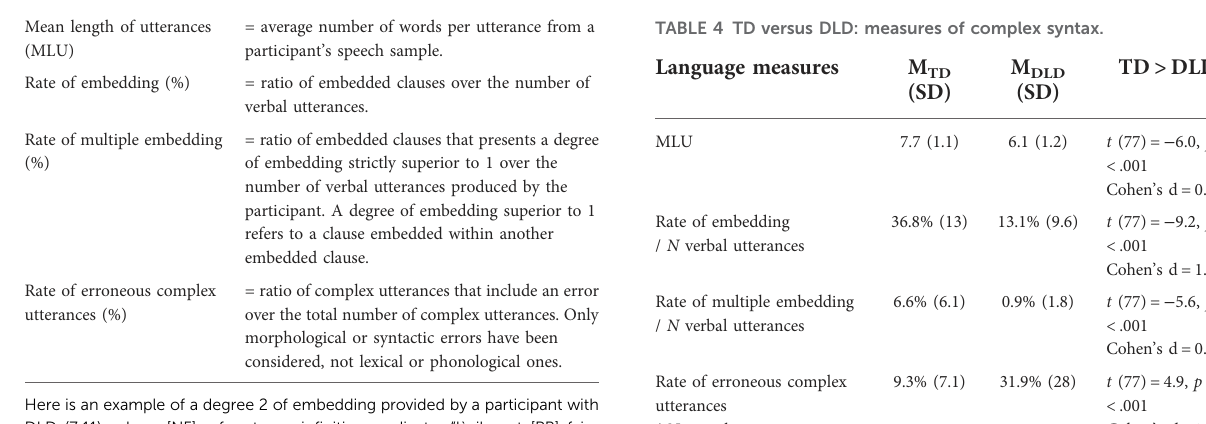
TABLE 3 Language